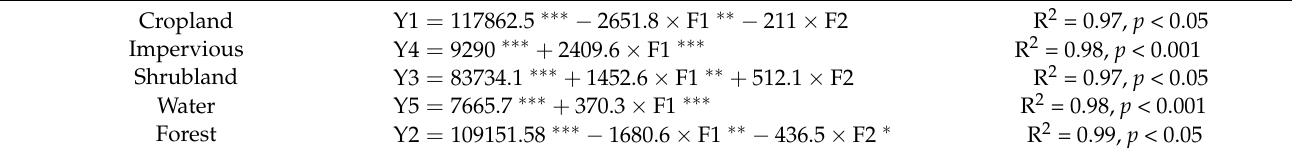
Table 5. Relationships between land-cover change and principal components in different